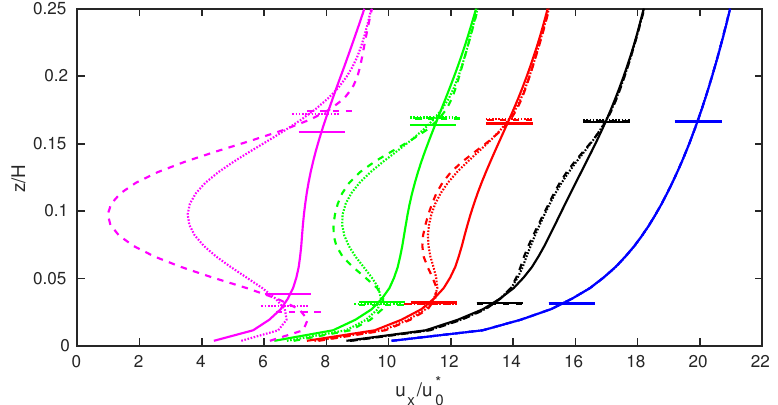
Figure 10. Streamwise velocity profiles in the vertical plane at turbine center. In each group, solid lines = 1 diameter upstream of turbine, dashed = 1 D downstream, dotted = 2 D downstream. The groups, = [ 3.0, 0.6, 0.3, 0.1, 0.0 ] . Some cases are omitted for the sake of in order from left to right, have C (cid:48) T clarity. Horizontal lines indicate the height of the streamtube at different downstream